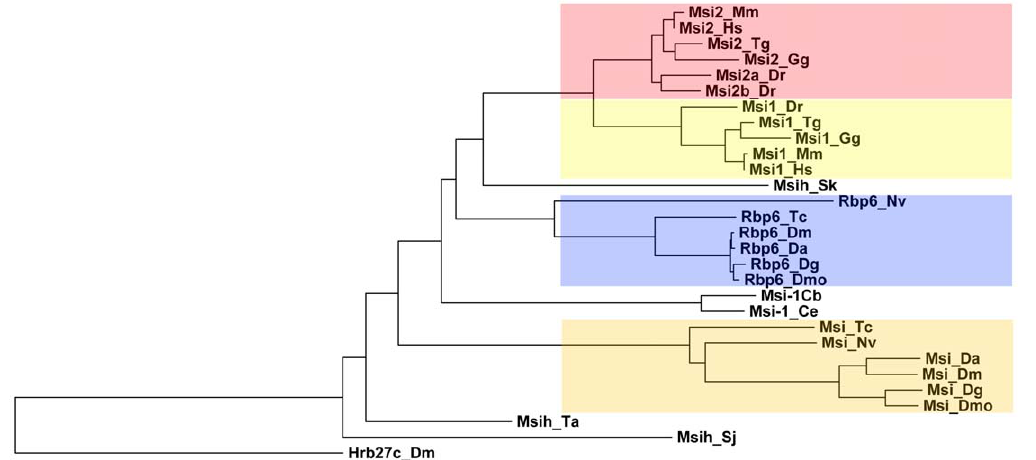
Figure 2. Phylogram of Msi family sequences. Vertebrates contain two Msi paralogues, Msi2 (red box) and Msi1 (yellow box). A single orthologue found in the hemichordate (Msih_Sk) is closely aligned with the vertebrate sequences. The Rbp6 clade (blue box) of Msi proteins is insect- specific but also more closely aligned with the vertebrate proteins than the single orthologues found in nematodes. The Msi clade (orange box) is a more highly derived insect-specific group of proteins. Single representatives of the Msi family can be found in Trichoplax and Schistosoma. The RRM- containing protein, Hrb27c, was used as an outgroup. Mm: Mus musculus (mouse), Hs: Homo sapiens (human), Gg: Gallus gallus (chicken), Tg: Taeniopygia guttata (zebra finch), Dr: Danio rerio (zebra fish), Sk: Saccoglossus kowalevskii (acorn worm/hemichordate), Nv: Nasonia vitripennis (jewel wasp), Tc: Tribolium castaneum (red flour beetle), Dm: Drosophila melanogaster (fruit fly), Da: Drosophila ananassae (fruit fly), Dg: Drosophila grimshawi (fruit fly), Dmo: Drosophila mojavensis (fruit fly), Ce: Caenorhabditis elegans (nematode), Cb: Caenorhabditis briggsiae (nematode), Ta: Trichoplax adhaerens (placozoan), Sj: Schistosoma japonicum (blood fluke).